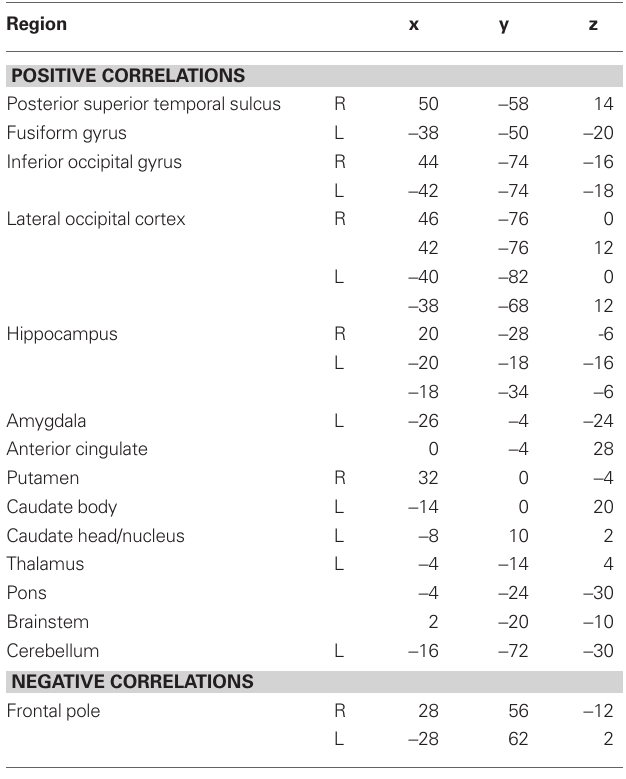
Table 1 | Resting partial Fg connectivity in experiment